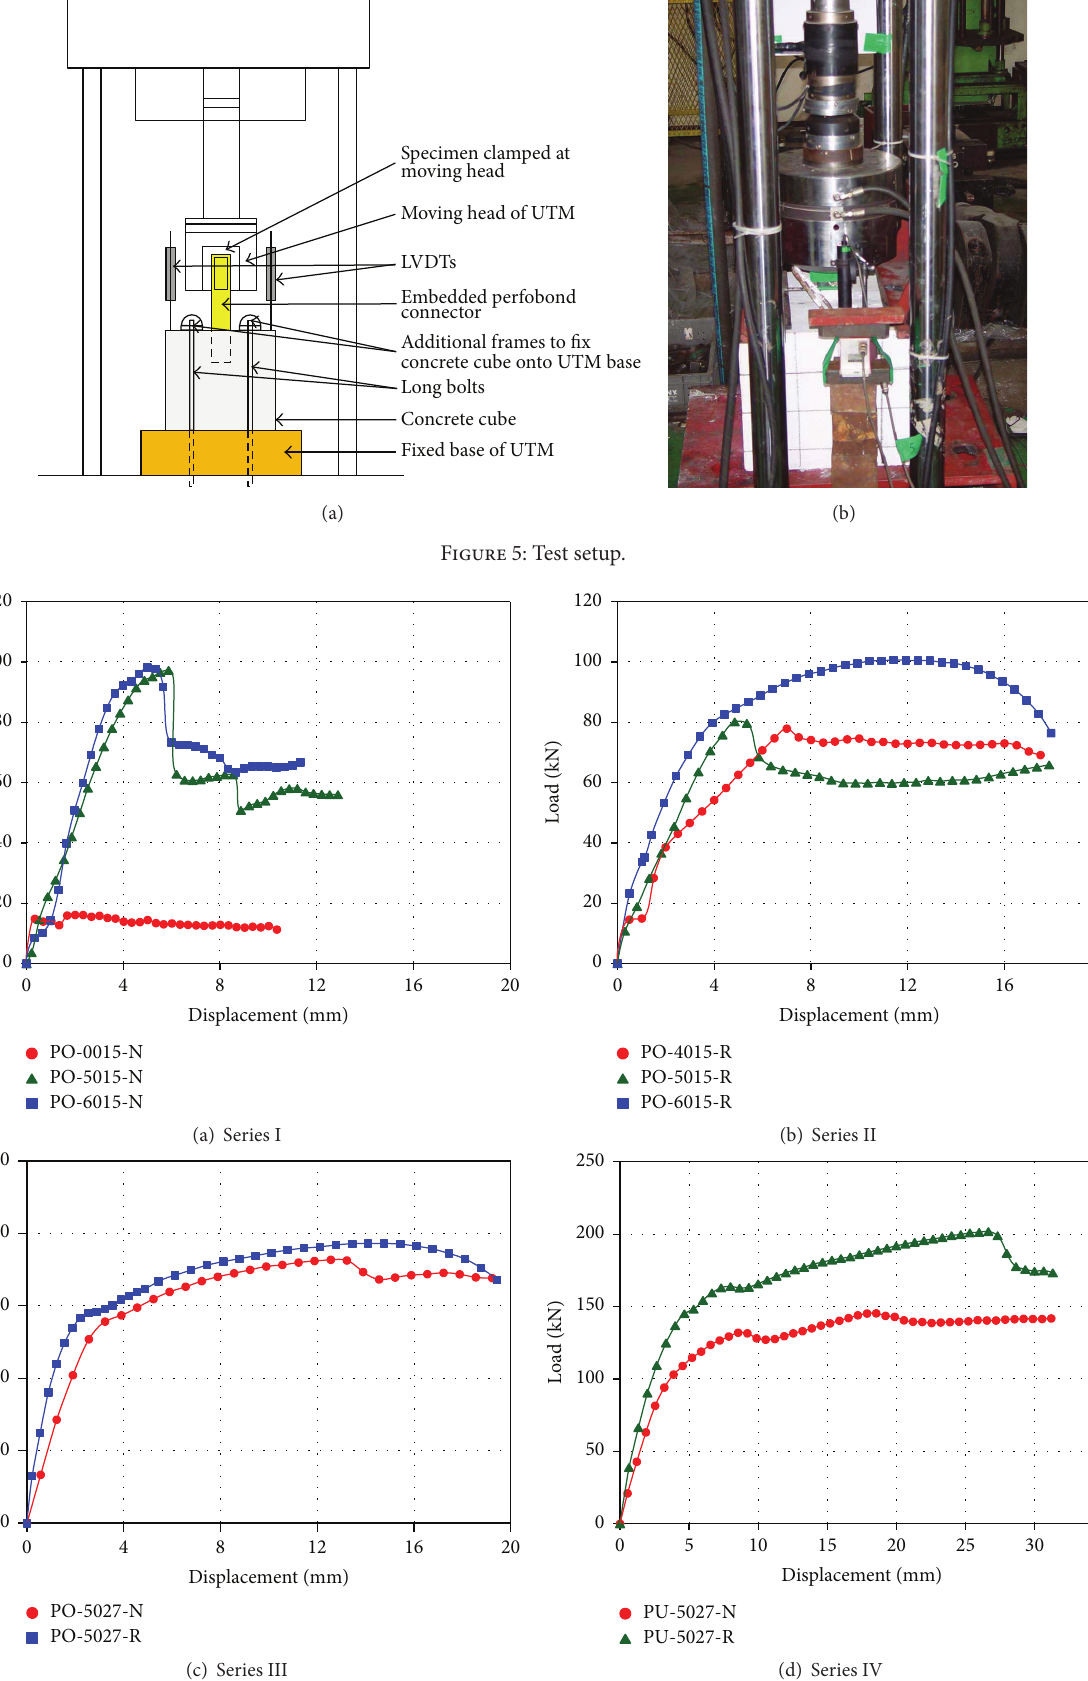
Figure 5: Test setup.